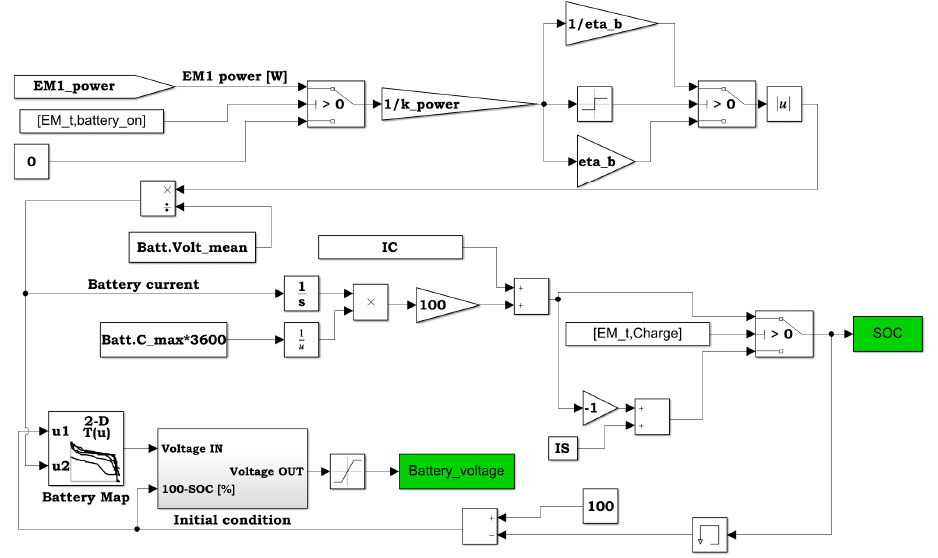
Figure 9. The battery model.